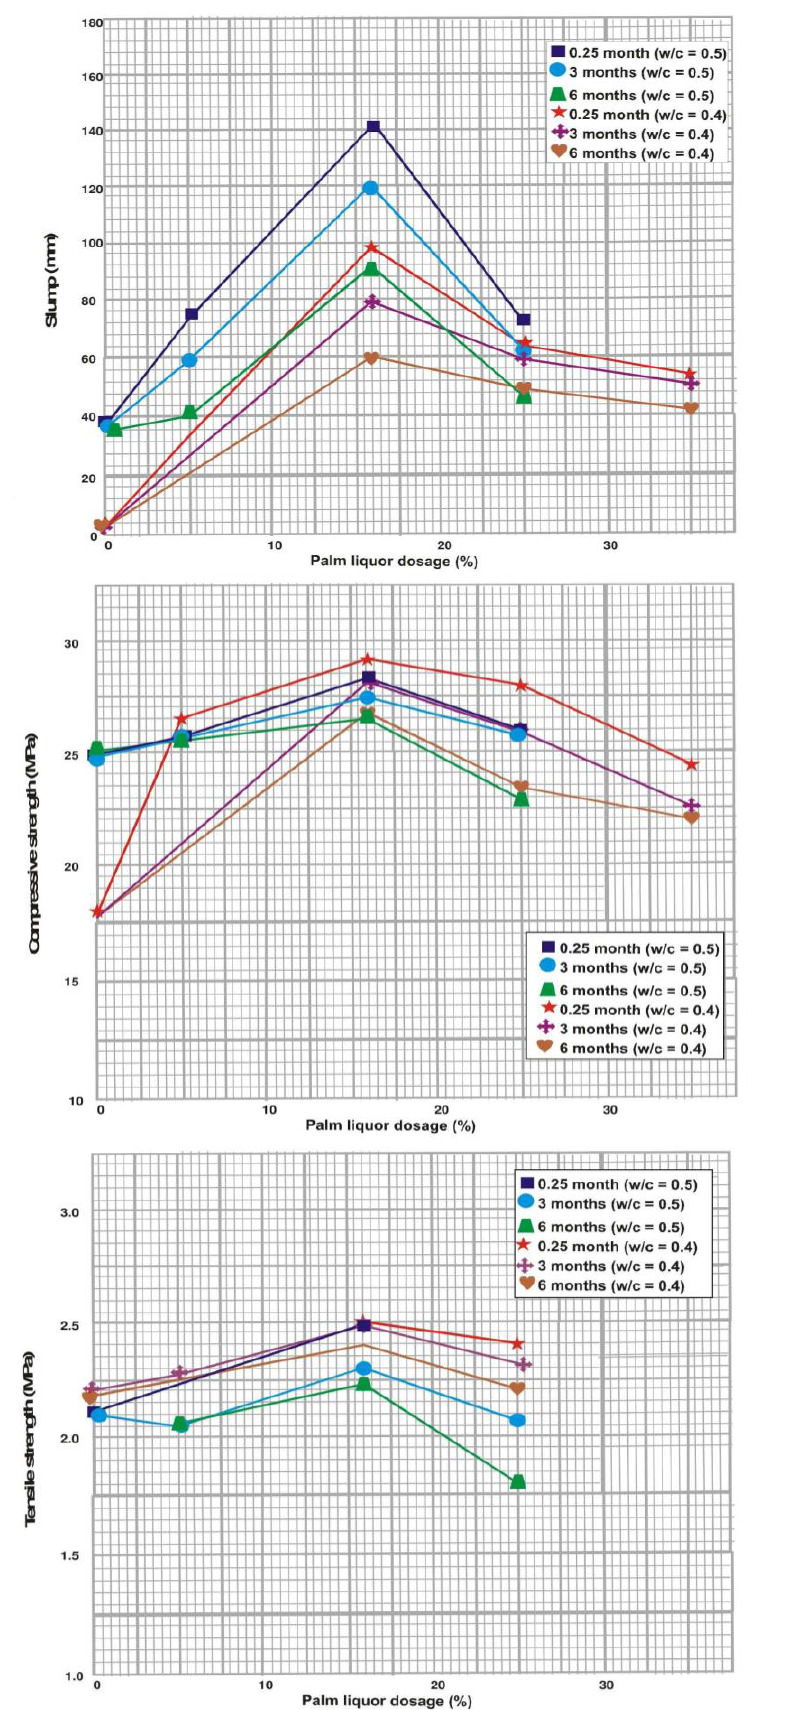
Figure 1. Test results palm liquor with different water/cement ratios (Otoko and Ephraim